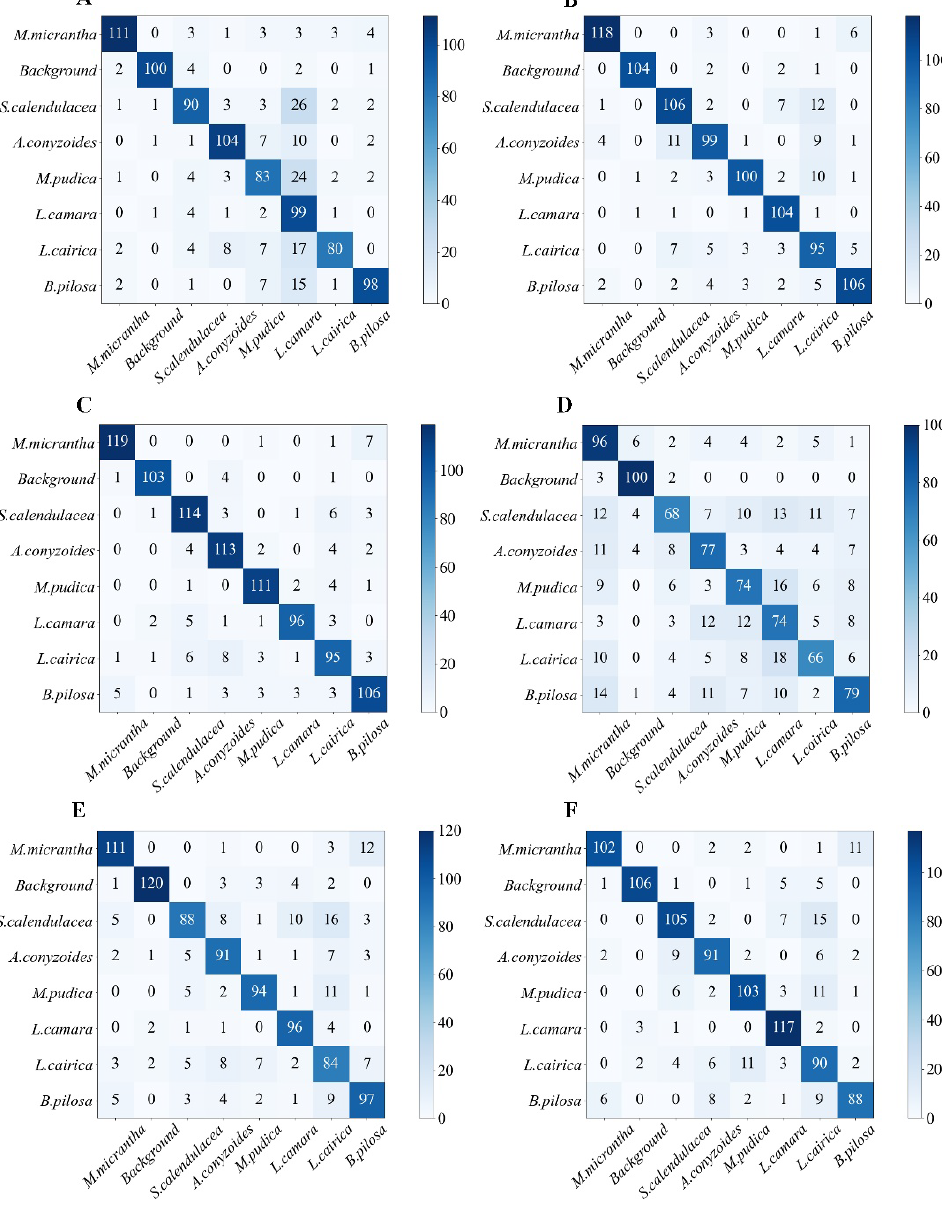
Figure 5. Confusion matrices of the combined models, ( A ) SNV-PCA-SVM, ( B ) SG-ACO-SVM, ( C ) SG-SVM, ( D ) SNV-PCA-RF, ( E ) SG-ACO-RF, ( F ) Table 2. Recognition accuracy of combined model for single species.